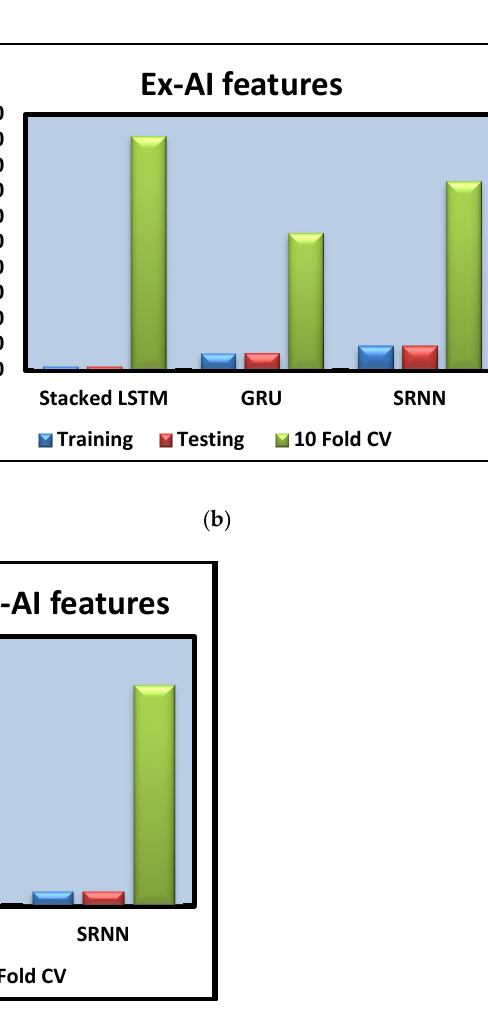
Figure 11. ( a – c ) RMSE values from three models. ( a ) All features. ( b ) Ex-AI features. ( c ) Jellyfish- optimized EX-AI features.